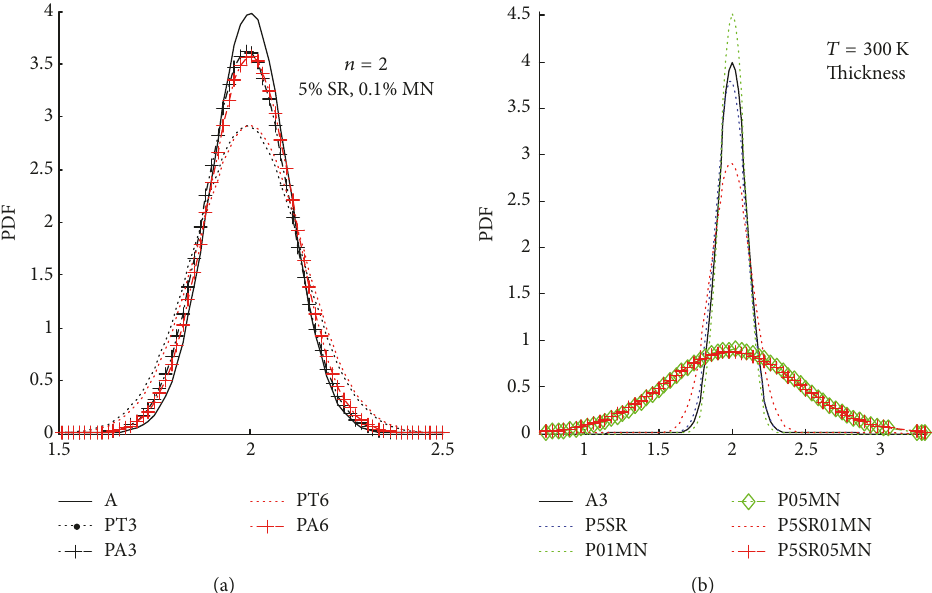
Figure 12: Identified PDFs of volume fraction index for different